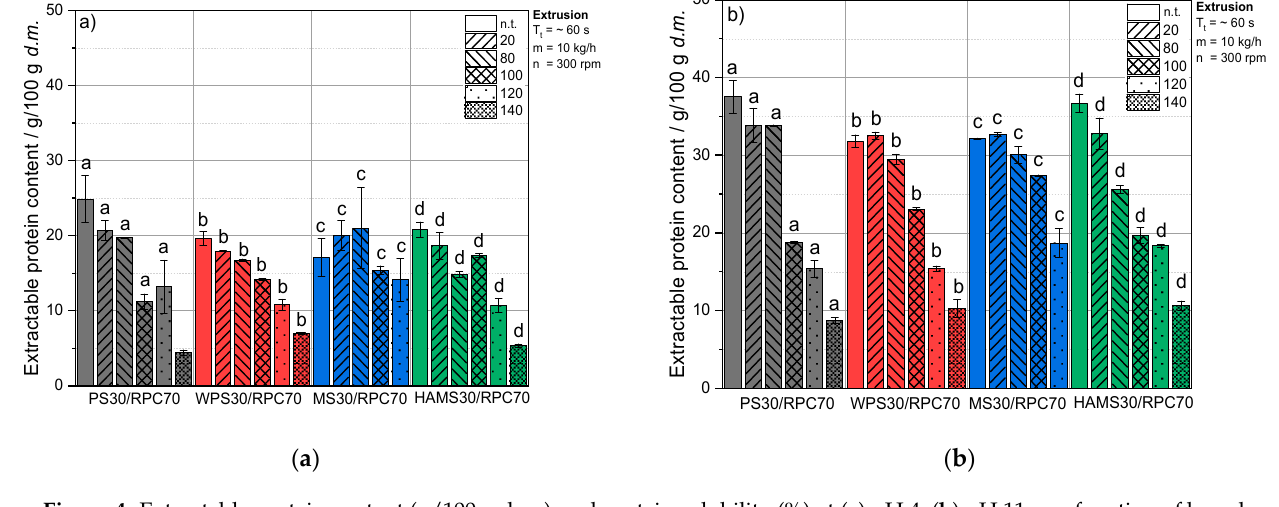
Figure 4. Extractable protein content (g/100 g d.m.) and protein solubility (%) at ( a ) pH 4, ( b ) pH 11 as a function of barrel temperature T B (20, 80, 100, 120 or 140 °C) of starch/RPC blends containing 70 g/100 g w.b. RPC and 30 g/100 g w.b. potato starch (PS), waxy potato starch (WPS), maize starch (MS) or high-amylose maize starch (HAMS). Mean values with different superscript letters indicate significant differences ( p < 0.05) between the starch types based on a two-way analysis of variance (ANOVA). Where appropriate, the mean values were compared using Tukey’s honest significance test. n.t. = not treated.